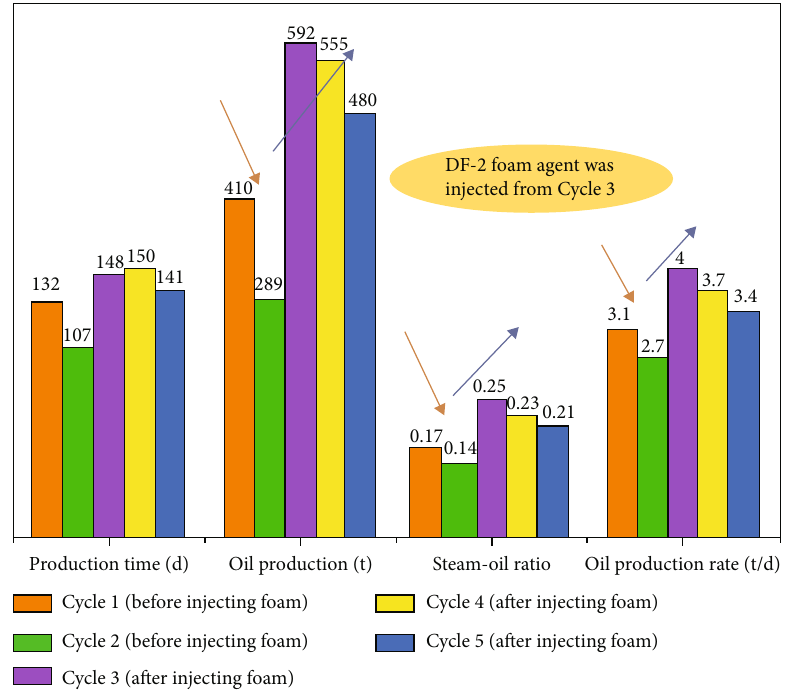
Figure 8: Statistical table of production e ff ect of pro fi le control in M-12 Oil fi eld block.